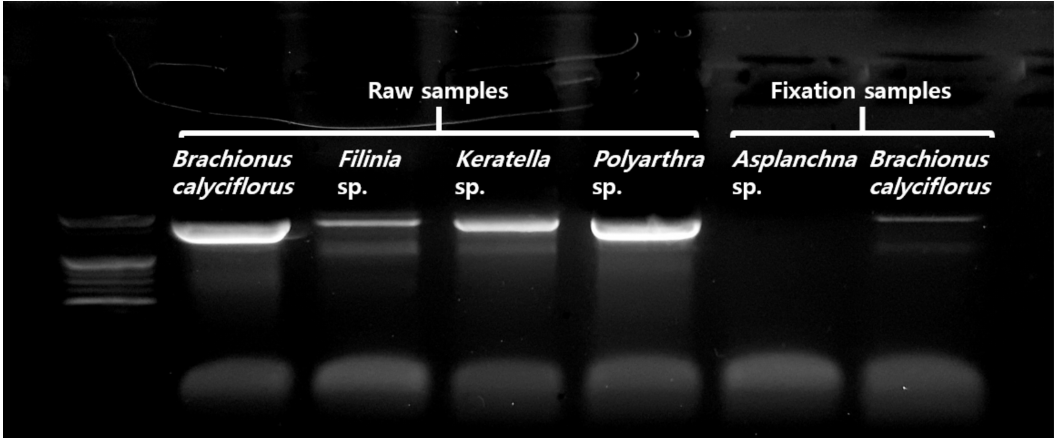
Figure A1. Results of applying Euk universal eukaryotic primers on each rotifer species (Raw samples: collected in the fresh water samples in the Shin-gal reservoir, fixation samples: stored in the